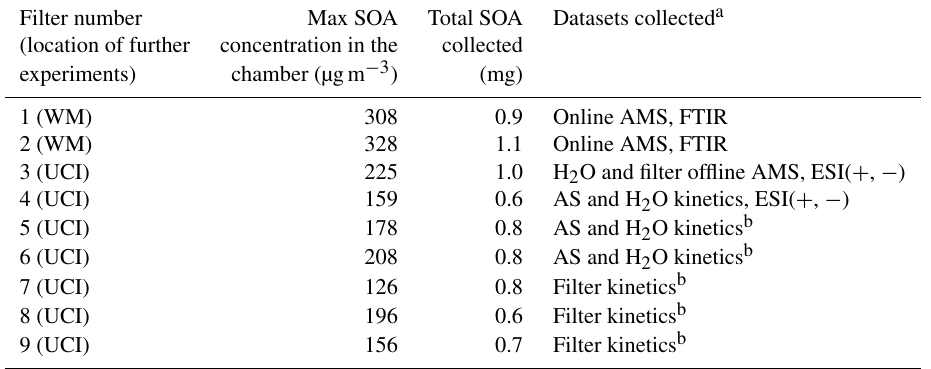
Table 1. Summary of samples prepared and the experiments they were used for at William and Mary (WM) and University of California Irvine (UCI). ESI signifies electrospray